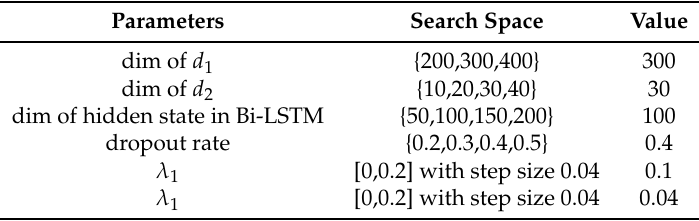
Table 4. Hyper-parameters for the global model. We use Adam for optimization, with learning rate of